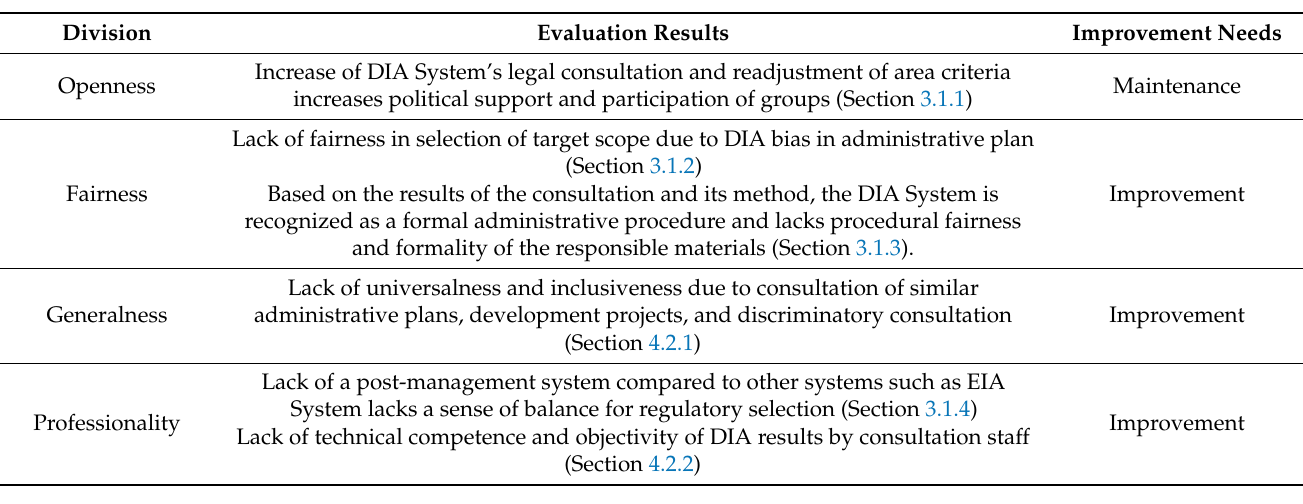
Table 5. Evaluation results and improvement needs of regulatory